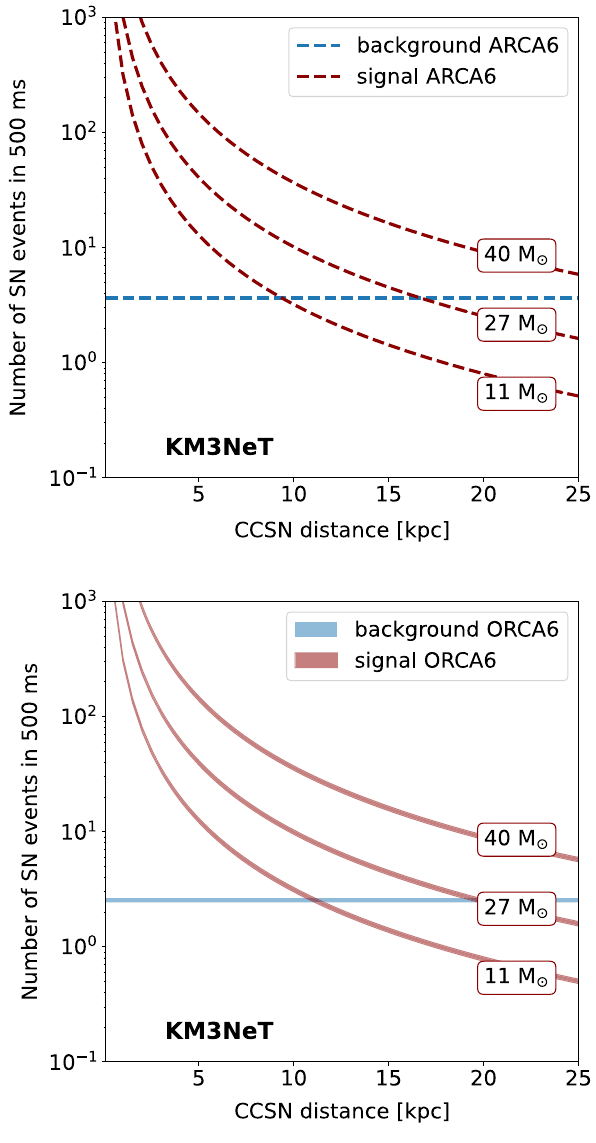
Fig. 5 Expected number of signal events in the ARCA6 (top) and ORCA6(bottom)detectorscomparedtotheirbackgroundexpectations. The 27M (cid:3) model considered in Ref. [14] is taken as a benchmark. The average photon detection efficiency of the PMTs of the two detectors is taken into account to determine the signal expectation. The instrumen- tation efficiency is accounted for by considering its variation within the interval corresponding to a cumulative livetime fraction of 68% (see Fig. 2). Its effect is reflected on the signal and background expectations of ORCA6 (red and blue bands), while it is negligible for ARCA6 (red and blue dashed lines)